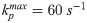
Membrane dynamics in the regime that cross-linking and retrogarde flow are balanced.(a) Initial (b) early and (c) late steady configuration of the membrane for na = 0.1 nm−1, Fe = 12 pN, kpmax=60s-1. The insets in panels (a)-(c) shows the filaments status under the membrane. The light-blue lines represent the free fluctuating filaments while the black line shows the filaments in their attached state. The red line shows the non-progressive gel front located at y = 0. (d) Time evolution of the middle point of the membrane and the little arrows show the points where the data for the (a)-(c) plots are collected.